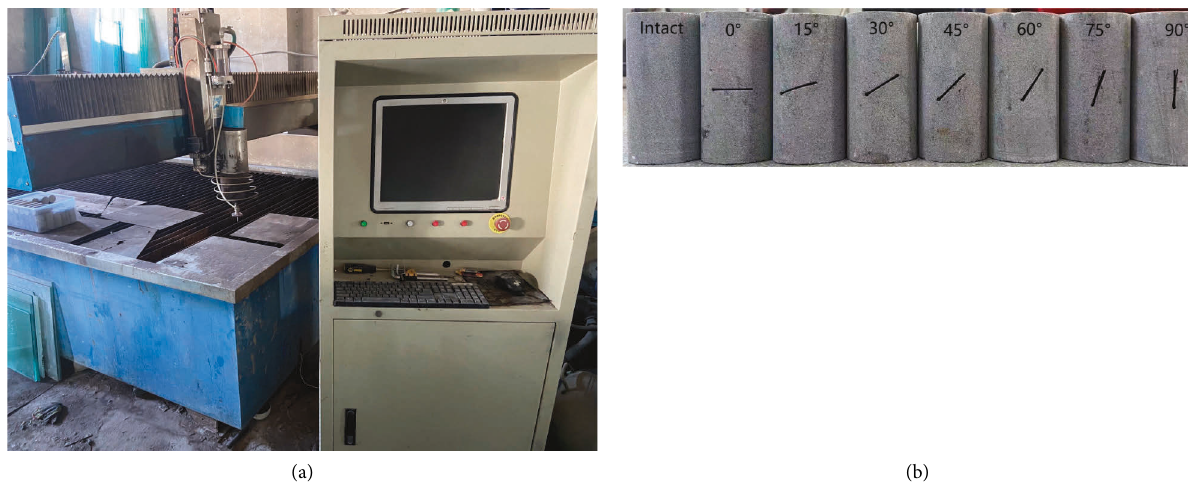
Figure 1: A sample preparation diagram. (a) SQ3020 CNC ultrahigh pressure water jet cutting machine. (b) Arrangement of fissure rock